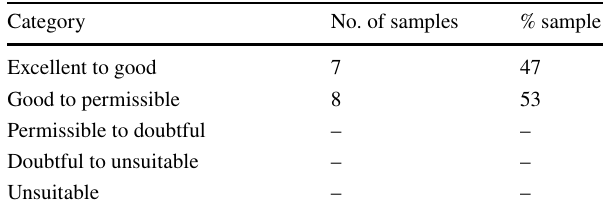
Table 6 Categorization of groundwater based on Wilcox